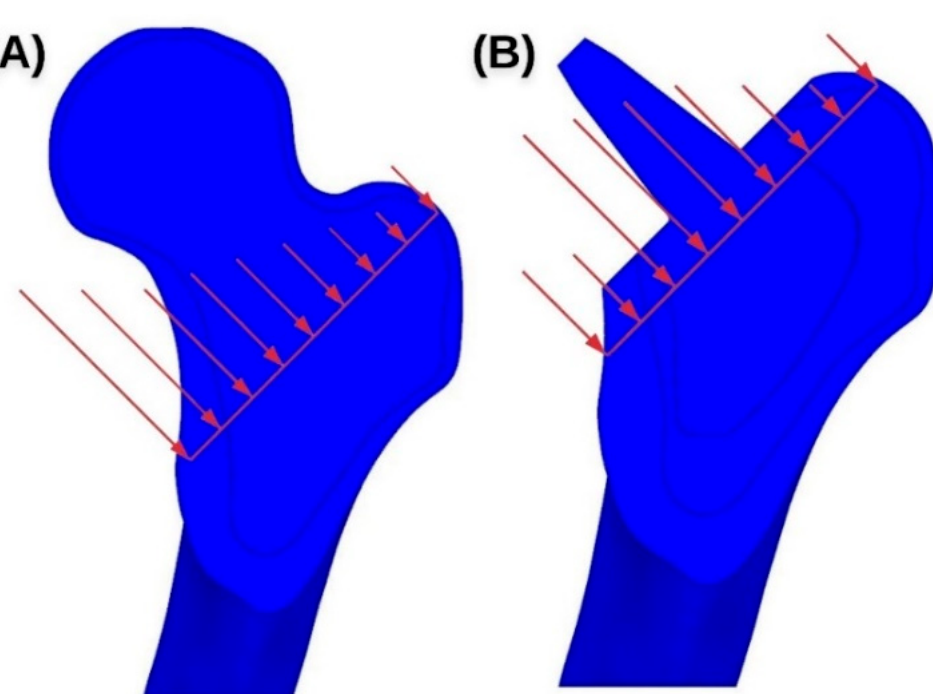
Figure 19. Stress distribution in ( A ) intact femur and ( B ) implanted femur. The lengths of the arrows are proportional to maximum principal stresses.